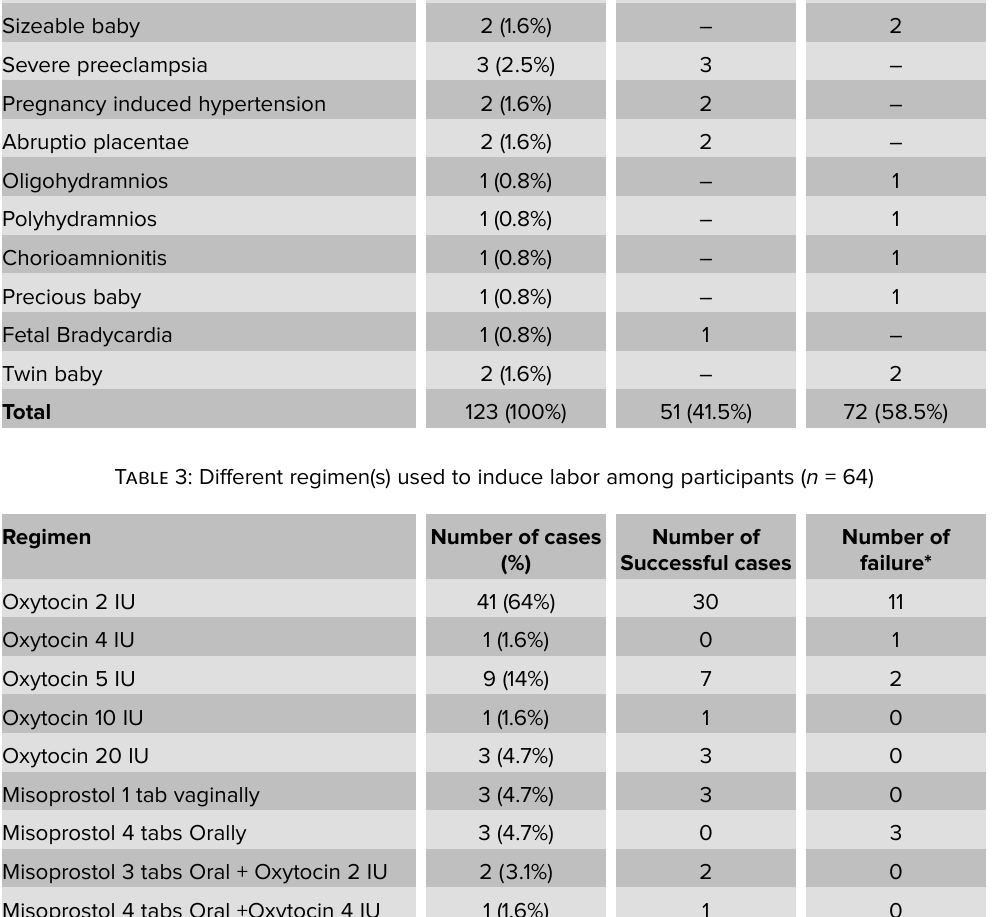
Misoprostol 1 tab